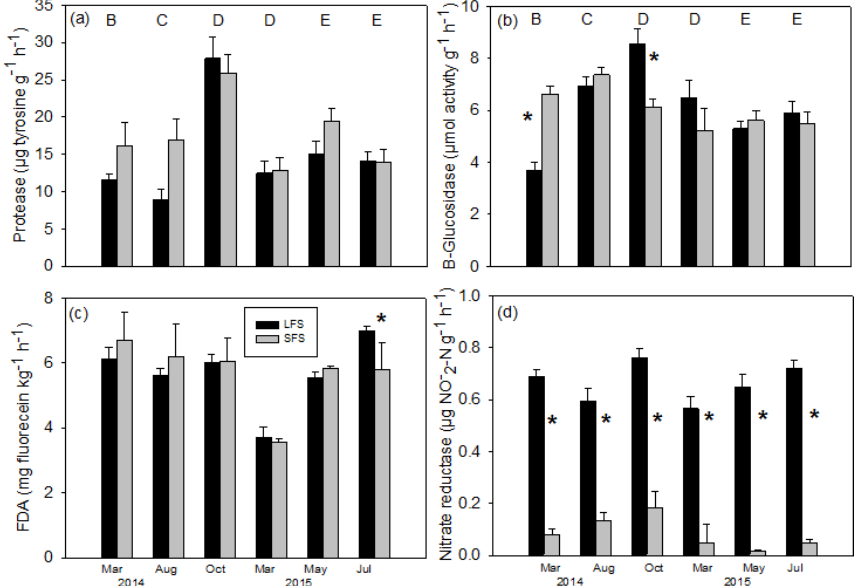
Figure 6. Soil enzymatic activities of (a) protease, (b) beta-glucosidase, (c) fluorescein diacetate and (d) nitrate reductase measured at different sampling dates from the LFS and SFS. Periods corresponding to different sampling dates are indicated by different letters (see Fig. 3). Values are mean ± SE ( n = 4–6). Asterisks indicate a significant difference between the LFS and SFS for the same sampling date at ( P < 0 .